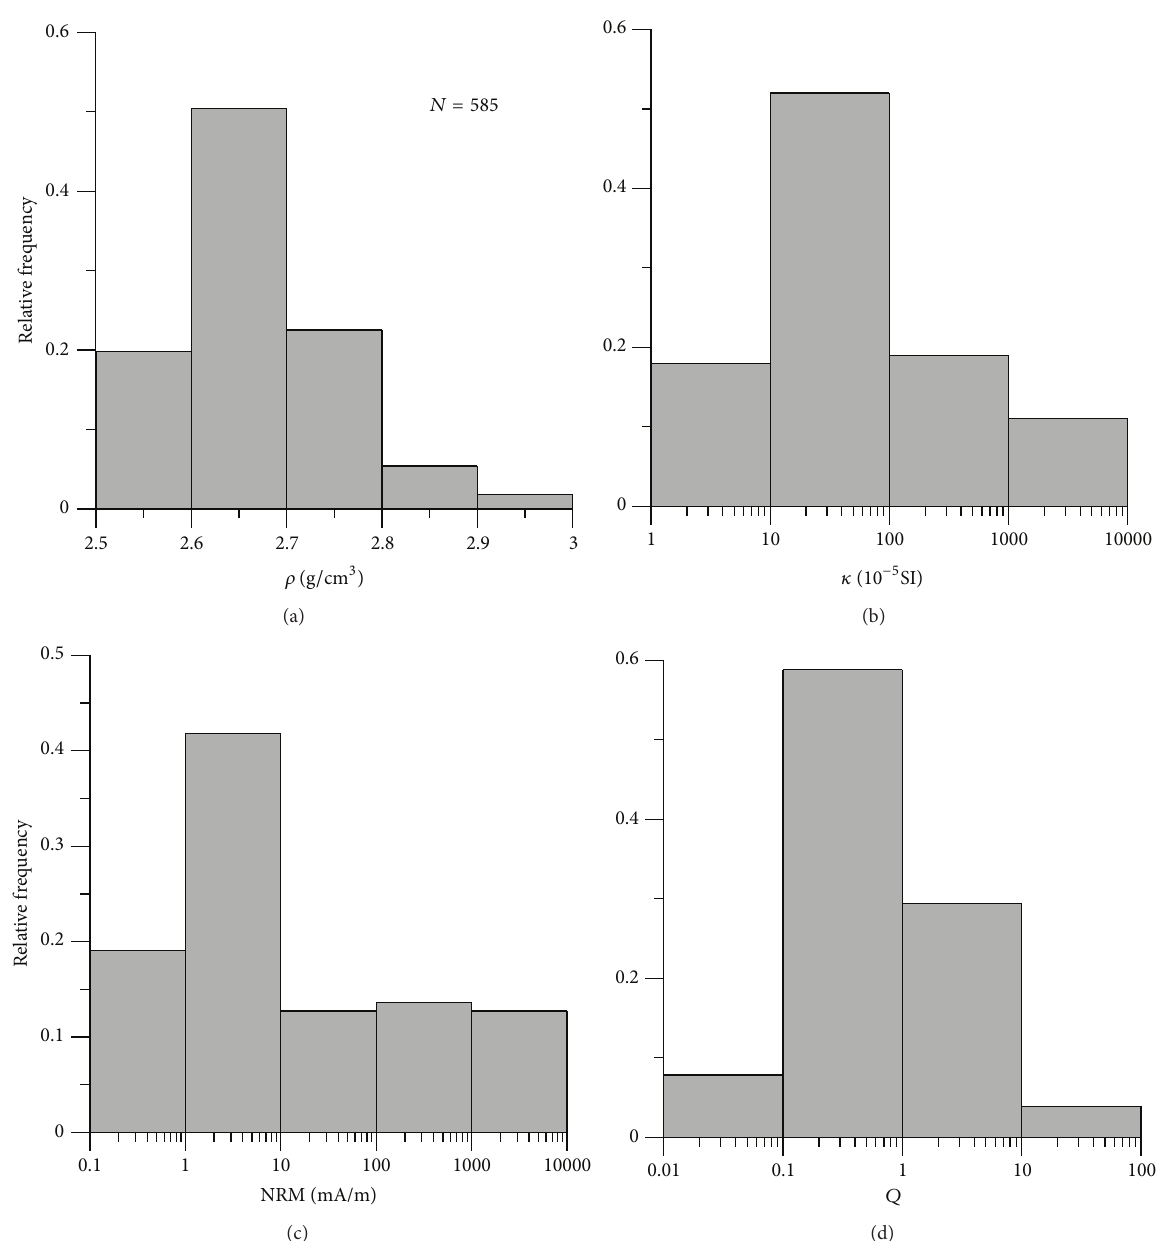
Figure 2: Histogram for (a) density (𝜌) , (b) magnetic susceptibility (𝜅) , (c) natural remanent magnetization (NRM), and (d) K¨oenigsberger ratio (𝑄) of all rock samples from the Suhbaatar-Ulaanbaatar-Dalandzadgad geophysical profile in Mongolia.